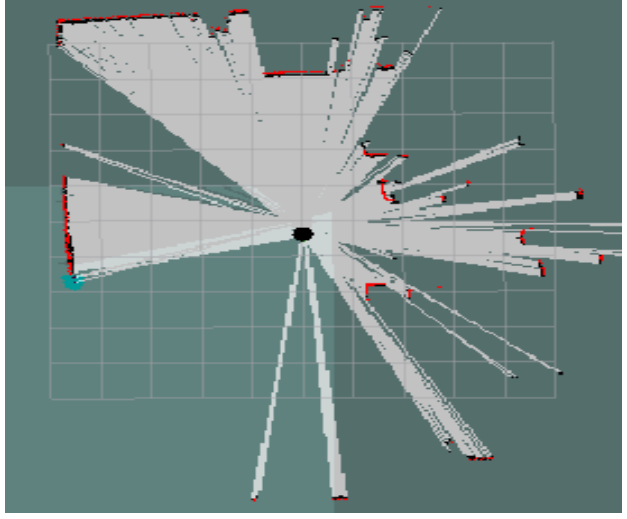
Figure 2. Local grid map of AGV.